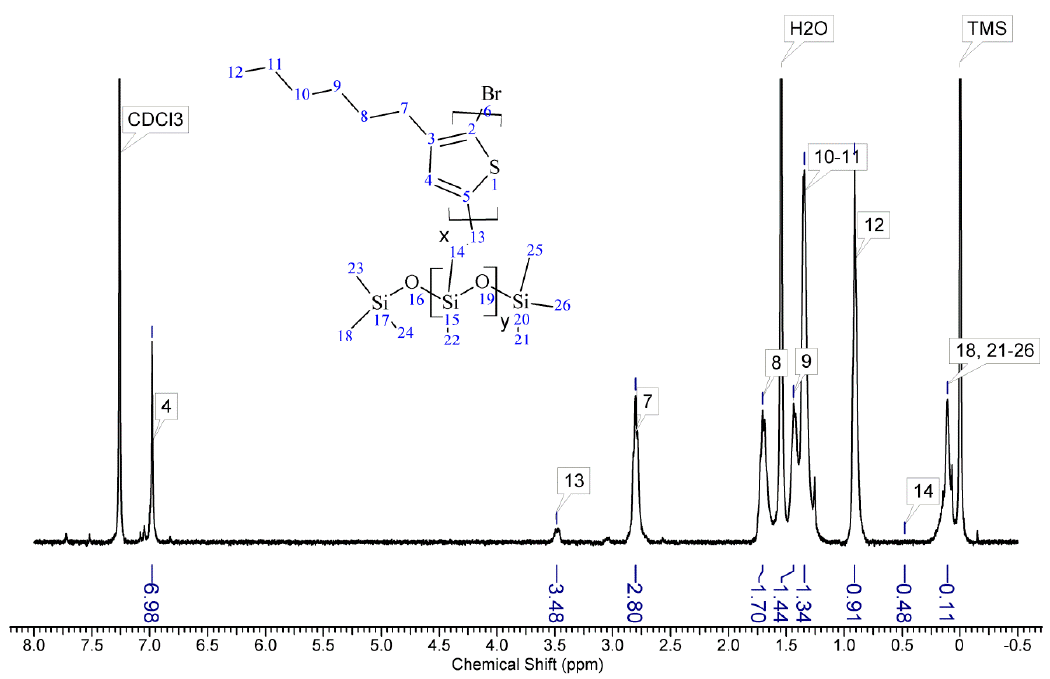
Figure A2. spectrum of poly(methylhydrosiloxane)-graft-poly(3-hexylthiophene) (composed ofchloroform fraction of vinyl terminated poly(3-hexylthiophene), poly(methylhydrosiloxane) average M n ≈ 390; chloroform fraction of graft copolymer) ( P3HT-Sil ).